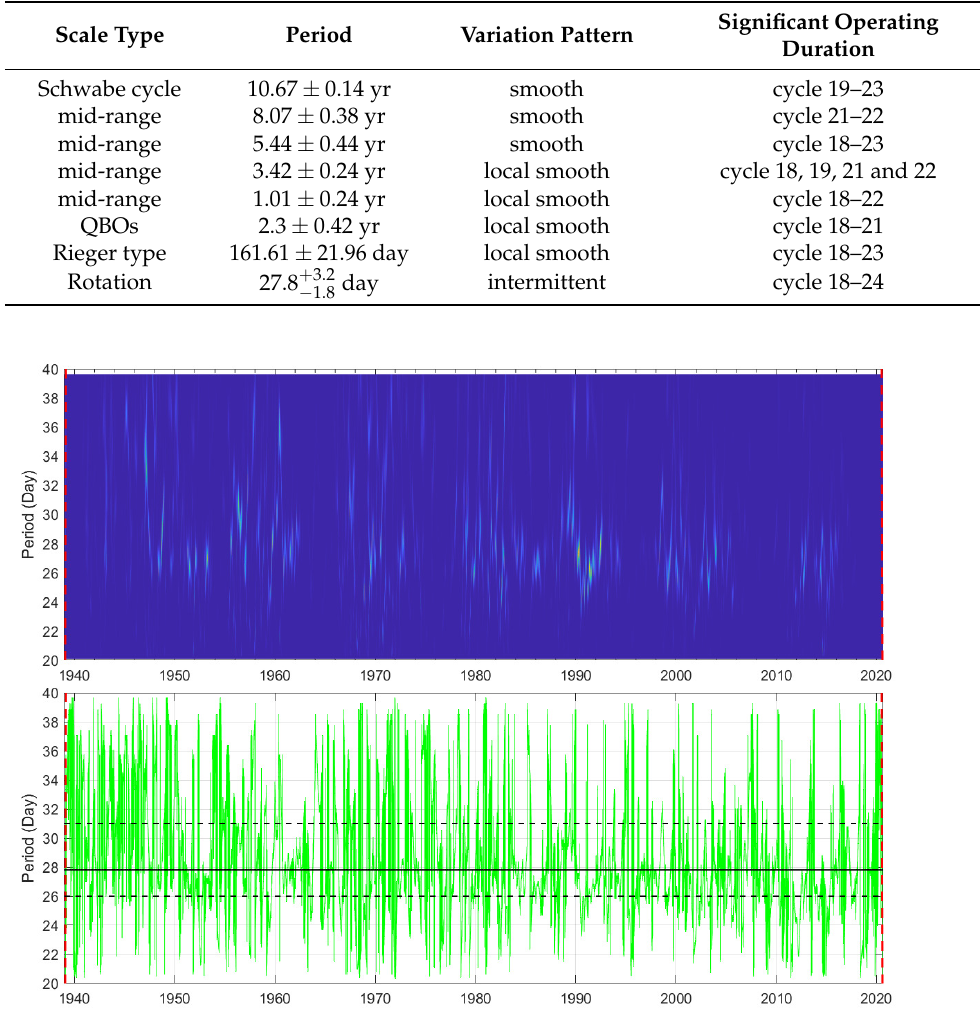
Table 1. The periodicities in the modified coronal index with variation patterns.